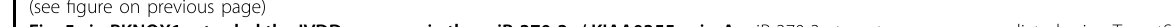
Fig. 5 circPKNOX1 retarded the IVDD process via the miR-370-3p/ KIAA0355 axis. A miR-370-3p target genes were predicted using TargetScan, miRDB, and miRTarBase. B After knocking down miR-370-3p, the expression level of KIAA0355 increased; *** P <0.001. Data represent mean±SD, and the P values were determined by a two-tailed unpaired Student ’ s t test. C In degenerated tissues, the expression of KIAA0355 decreased; ** P <0.01. Data represent mean±SD, and the P values were determined by a two-tailed unpaired Student ’ s t test. D The binding site of miR-370-3p and KIAA0355 was predicted using TargetScan. E After transfection with siKIAA0355, the expression of KIAA0355 decreased; ** P <0.01. Data represent mean ±SD, and the P values were determined by a two-tailed unpaired Student ’ s t test. The expression of related proteins (collagen II, aggrecan, SOX9, MMP3, MMP13, ADAMTS4, and ADAMTS-5) was observed by western blotting ( F ) after KIAA0355 knockdown and ( G ) after KIAA0355 and miR-370-3p knockdown. The fl uorescence intensity of related proteins (collagen II, aggrecan, ADAMTS4, and MMP13) (scale bar, 100 μ m) was observed via an immuno fl uorescence assay ( H ) after KIAA0355 knockdown and ( I ) after KIAA0355 and miR-370-3p knockdown. RT-qPCR was used to detect the expression levels of related genes ( J ) after KIAA0355 knockdown (* P <0.05, ** P <0.01. Data represent mean±SD, and the P values were determined by a two-tailed unpaired Student ’ s t test) and ( K ) after KIAA0355 and miR-370-3p knockdown (* P <0.05, ** P <0.01, *** P <0.001. Data represent mean±SD, and the P values were determined by a two-tailed unpaired Student ’ s t test.). Top: the extracellular matrix was detected by Alcian staining ( L )